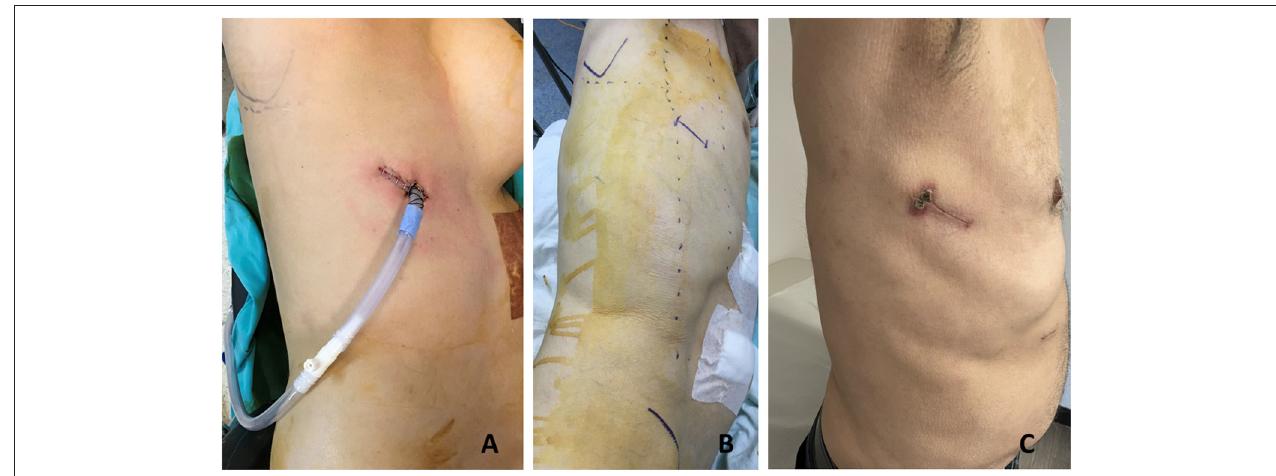
FIGURE 1 | The uniportal incision is made on the sixth intercostal space posterior axillary line. (A) In a 55-year-old female patient, we placed our incision between the anterior and posterior axillary lines. (B) Preoperative planning in a 57-year-old man. (C) One month appearance of a uniportal incision for esophageal mobilization in a 69-year-old patient.